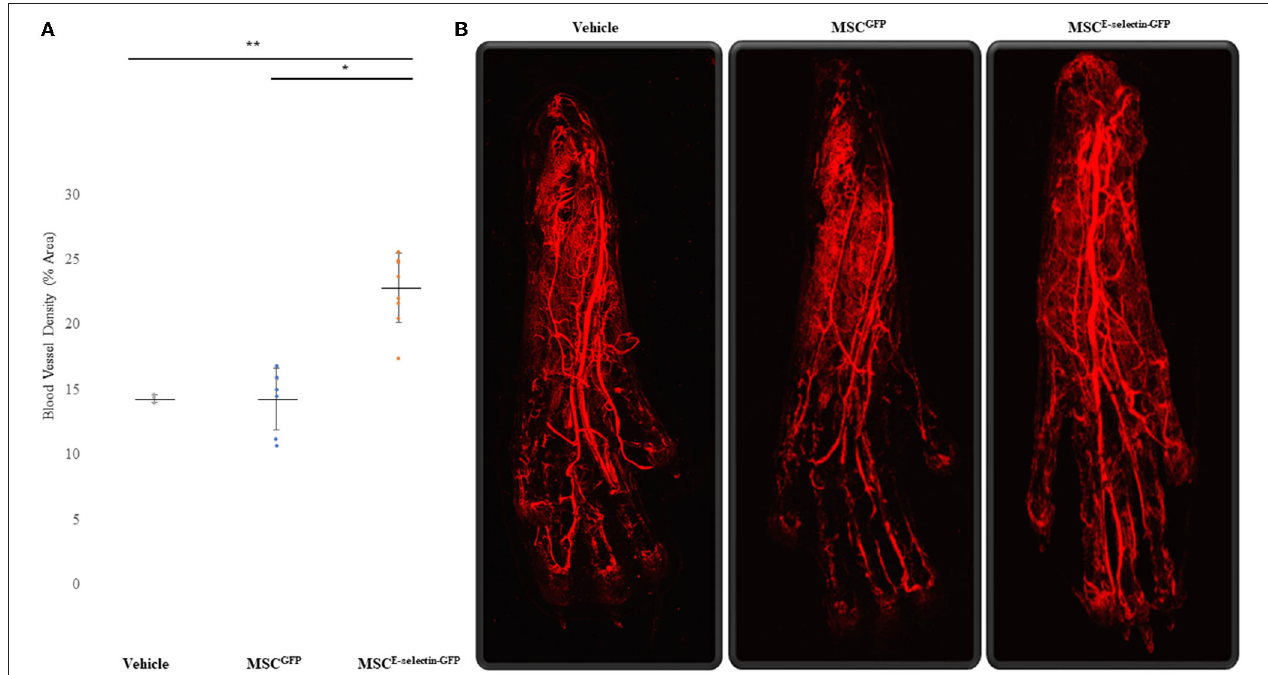
FIGURE 4 | Improved Blood Vessel Density of the Ischemic Distal Footpad after treatment with MSC E − selectin − GFP . (A) Qualitative analysis of the distal toe vessel density (% area, mean ± SD, ** P < 0.01 via ANOVA, * P < 0.05 post-hoc Tukey Simultaneous Tests for Differences of Means, Vehicle treatment n = 3, MSC GFP n = 8, MSC E − selectin − GFP n = 9). (B) Representative images of Z-stacked images of the ischemic footpads after DiI perfusion via Confocal laser